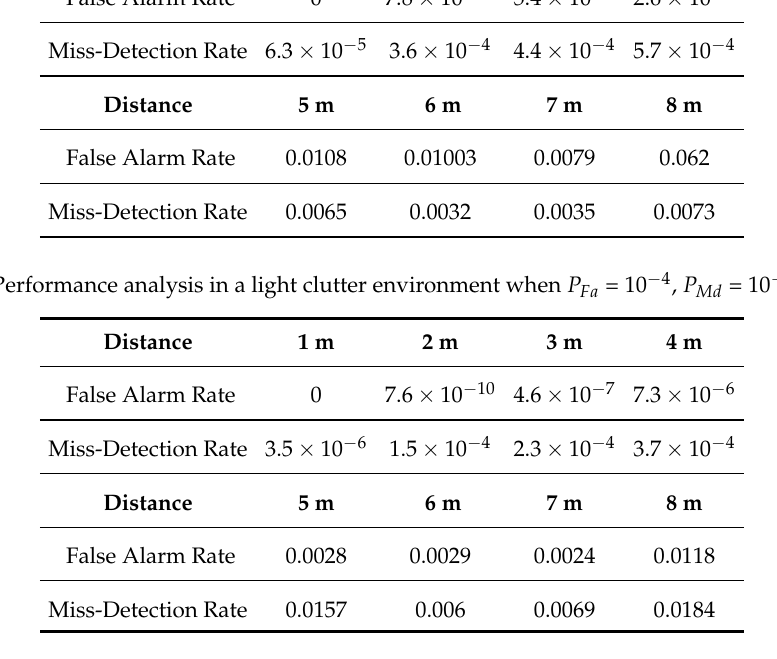
Table 4. Performance analysis in a light clutter environment when P Fa = 10 − 4 , P Md = 10 − 3 , α =